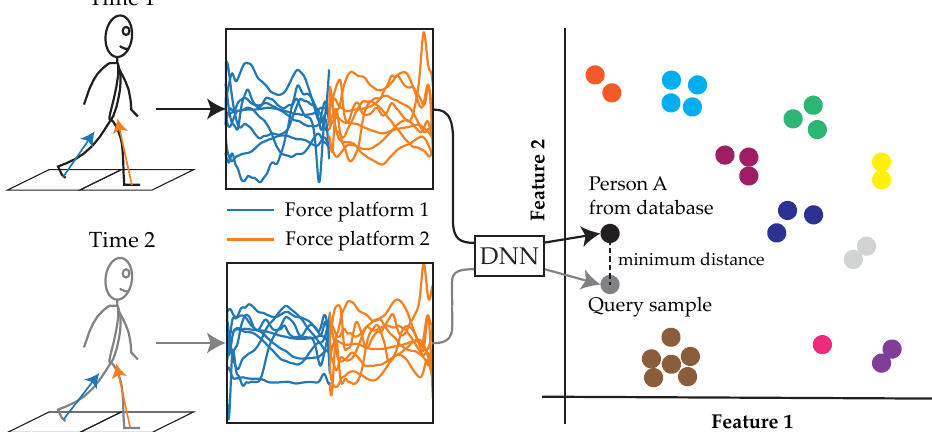
Figure 1. Workflow of person re-identification (re-ID) using a using a deep metric learning model. An unknown identity (ID) can be re-identified by extracting their gait features using a deep neural network (DNN) and comparing them to those of other samples in the database using a distance metric. Following this approach, the same trained model can be used to re-identify any number of IDs who were not seen during training. Unlabeled colors each represent a different ID. The feature space is depicted as two-dimensional for simplicity.